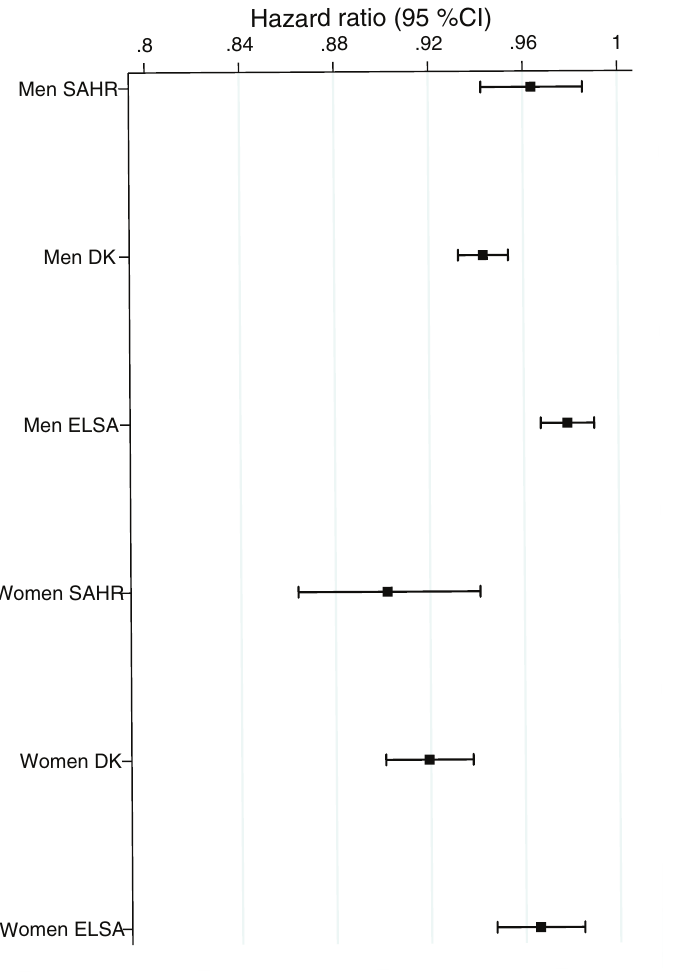
Fig 2. Hazard ratios for grip strength per 1-kg increasein SAHR, MADT and LSADT, and ELSA.